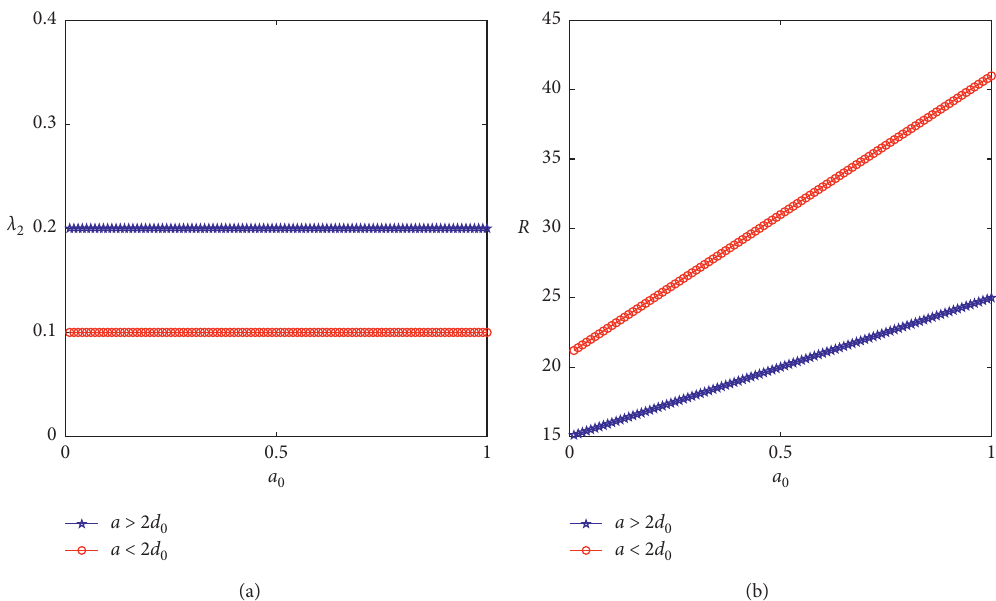
Figure 3: When N is odd, the synchronizability of Network I changes with the intralayer coupling strength a changes with a ( a changes from 0.01 to 1); (b) R changes with a 0 0